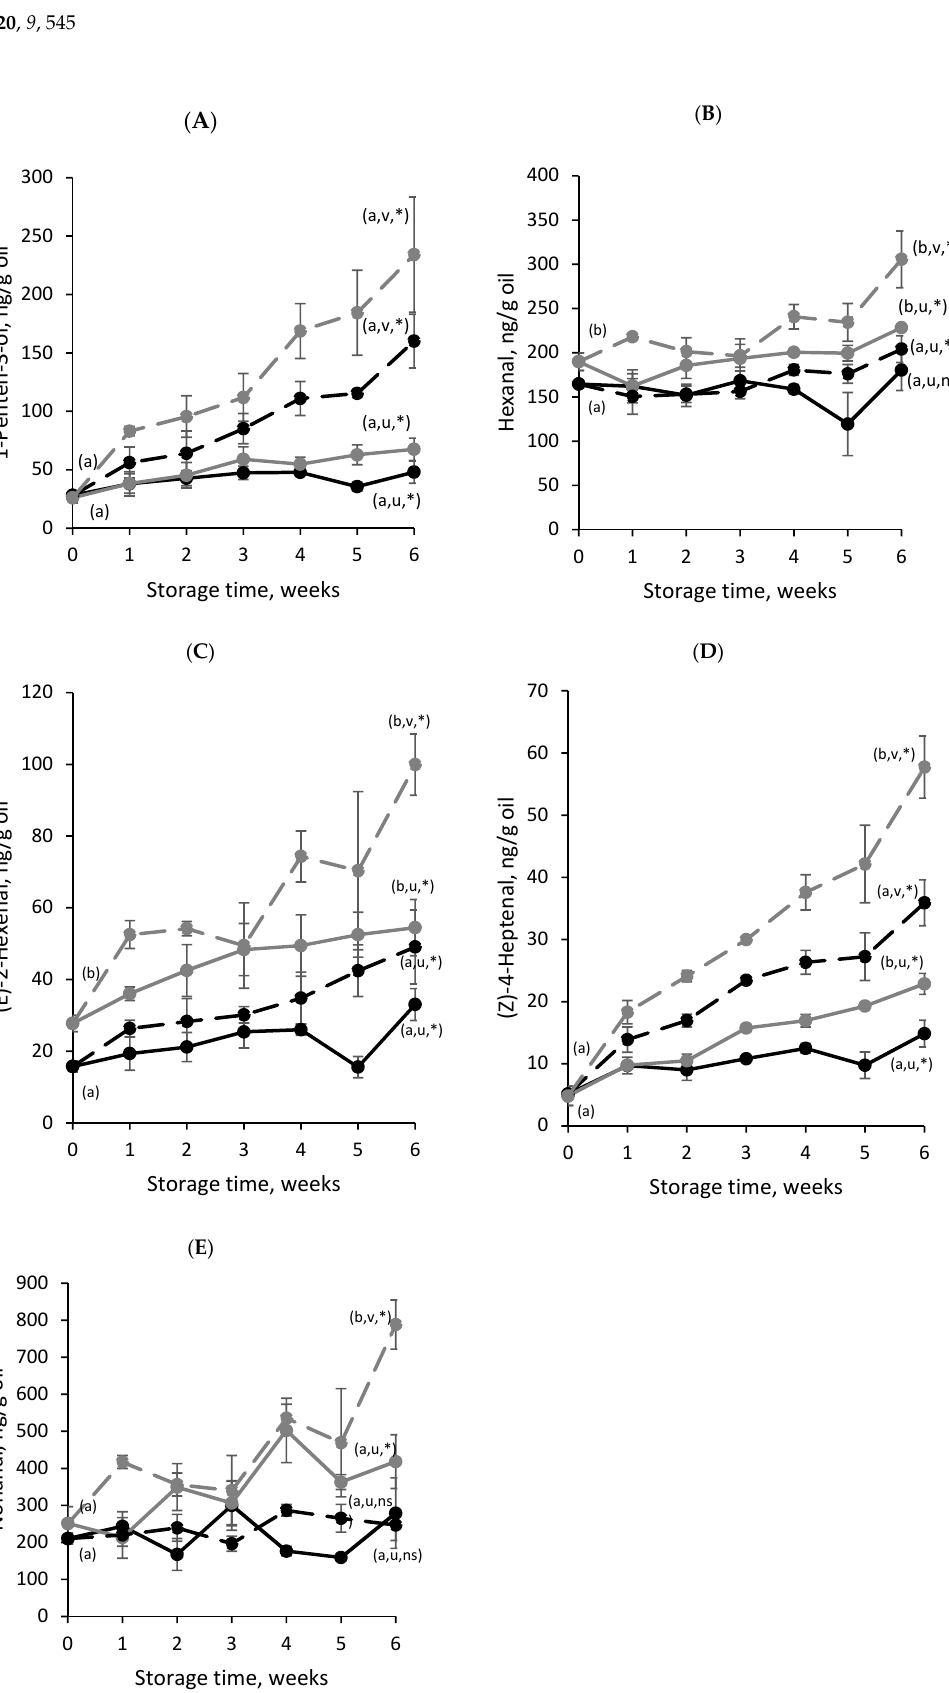
Figure 3. Secondary volatile oxidation products (1-penten-3-ol ( A ), hexanal ( B ), ( E )-2-hexenal ( C ), (Z)-4-heptenal ( D ) and nonanal ( E )) of spray-dried microcapsules loaded with fish oil during storage